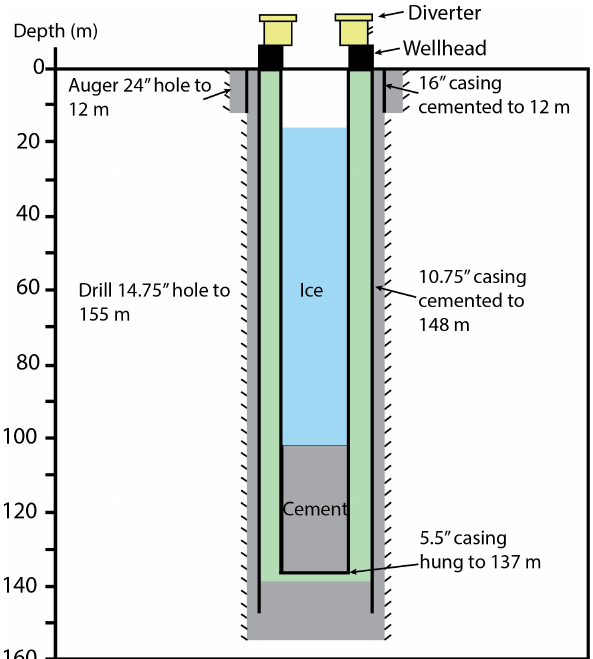
Figure 1. Schematic diagram of the North American Test